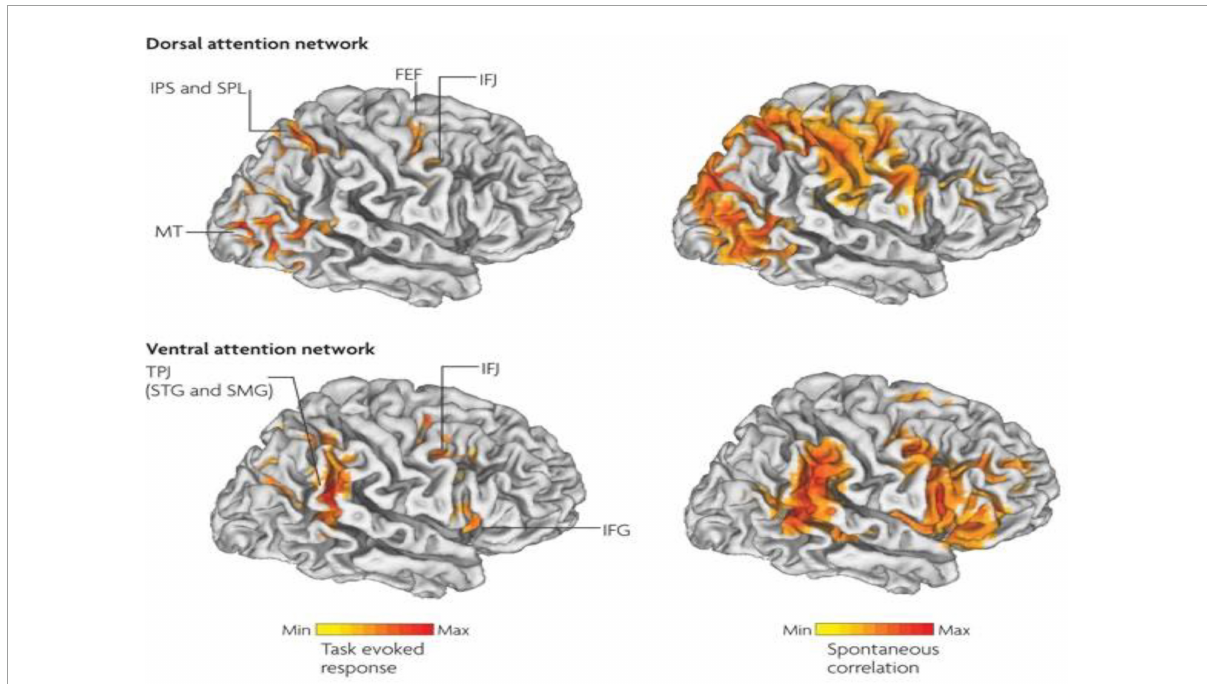
FIGURE2 Interaction between the dorsal attention networks and ventral (salience) enables active control of attention in relation to bottom-up sensory stimulation and top-down goals. The top-down dorsal-frontoparietal system which includes the frontal eye fields (FEF) and the intraparietal sulcus that supports voluntary attention to particular aspect of the visual field locations or objects and the ventral-frontoparietal system is concerned with attention to unexpected features. The ventral attention network involves the ventral-frontal cortex and the temporoparietal junction (TPJ), and usually responds to behaviorally relevant but unexpected stimuli. The biasing of sensory areas toward particular stimuli derives from the frontoparietal cortex. There exists a connection between sensory cortical areas involving the intraparietal sulcus and the FEF. These two areas have top-down influences on the orienting of attention. These top-down effects are known to out-weigh bottom up effects from the visual cortex (after Vossel et al., 2014 with